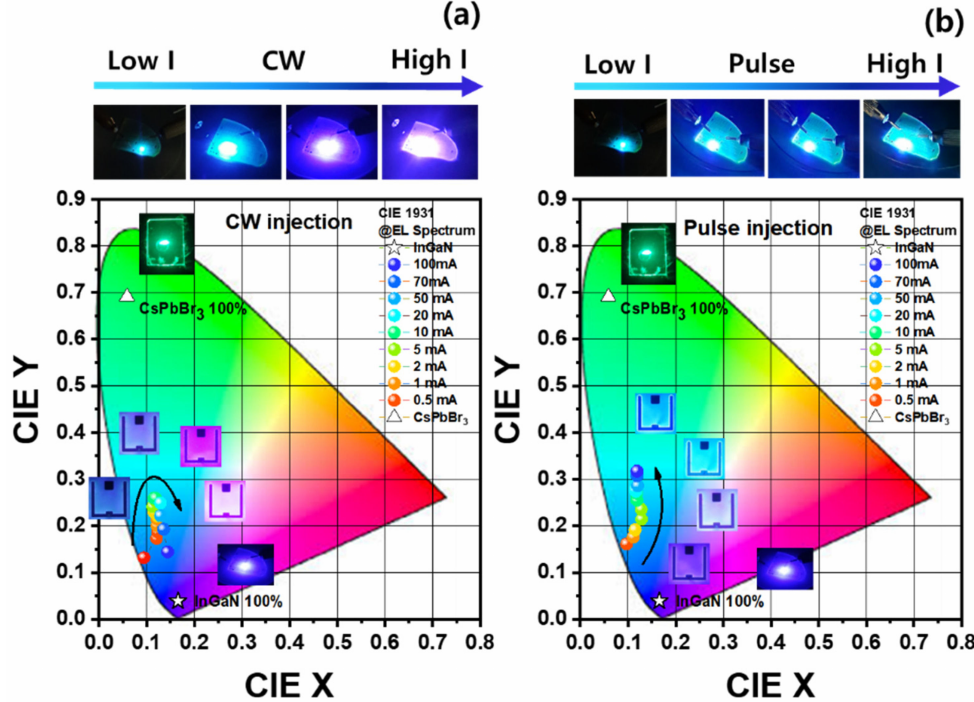
Figure 6. Color coordinate images of the hybrid LEDs using CsPbBr 3 QDs under ( a ) CW and ( b ) pulse injection currents. The insets are the EL images of the hybrid LED die and wafer with increasing injection